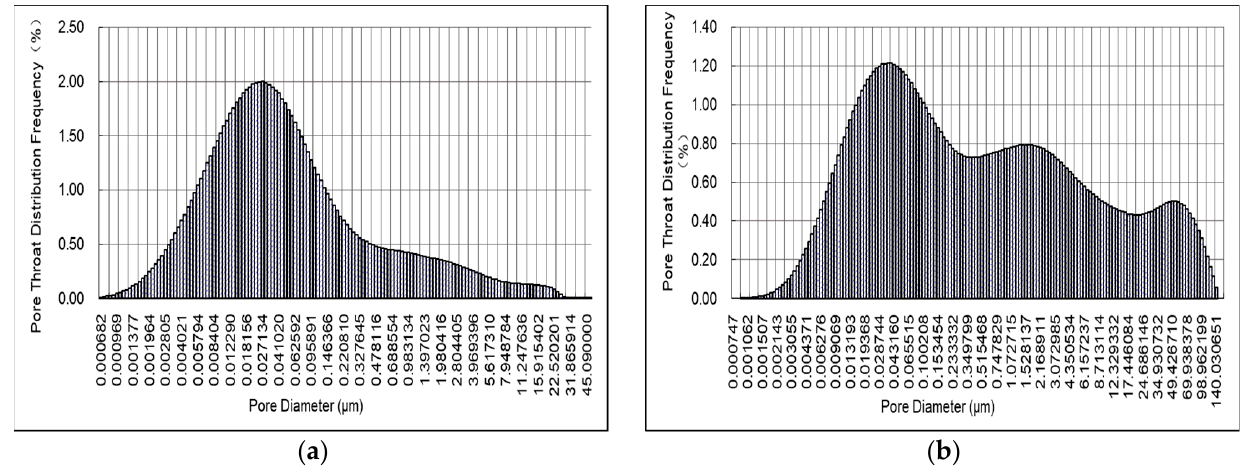
Figure 5. Distribution of core pore size (No. 9 of Well XX2-1-5): ( a ) before fracture; ( b ) After fracture.